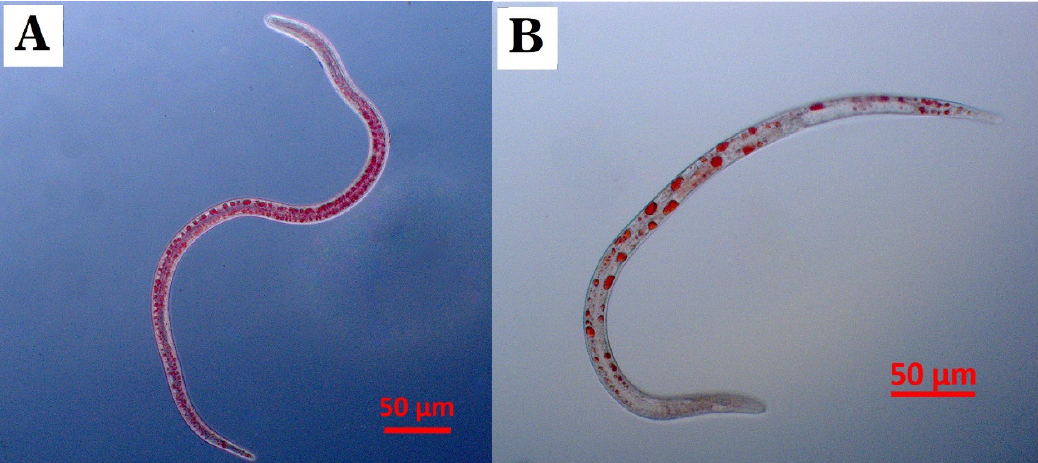
Figure 5. Pinewood nematode lipid content was shown by staining with oil red O in the presence and absence of pcyt-1 RNA interference (RNAi). Red spots indicate lipid drops. ( A ): PWN after RNAi for 48 h. ( B ): Control nematodes after culture 48 h. many lipid droplets were still present in PWN in the experimental group, whereas the number of lipid droplets in the control group was markedly reduced.